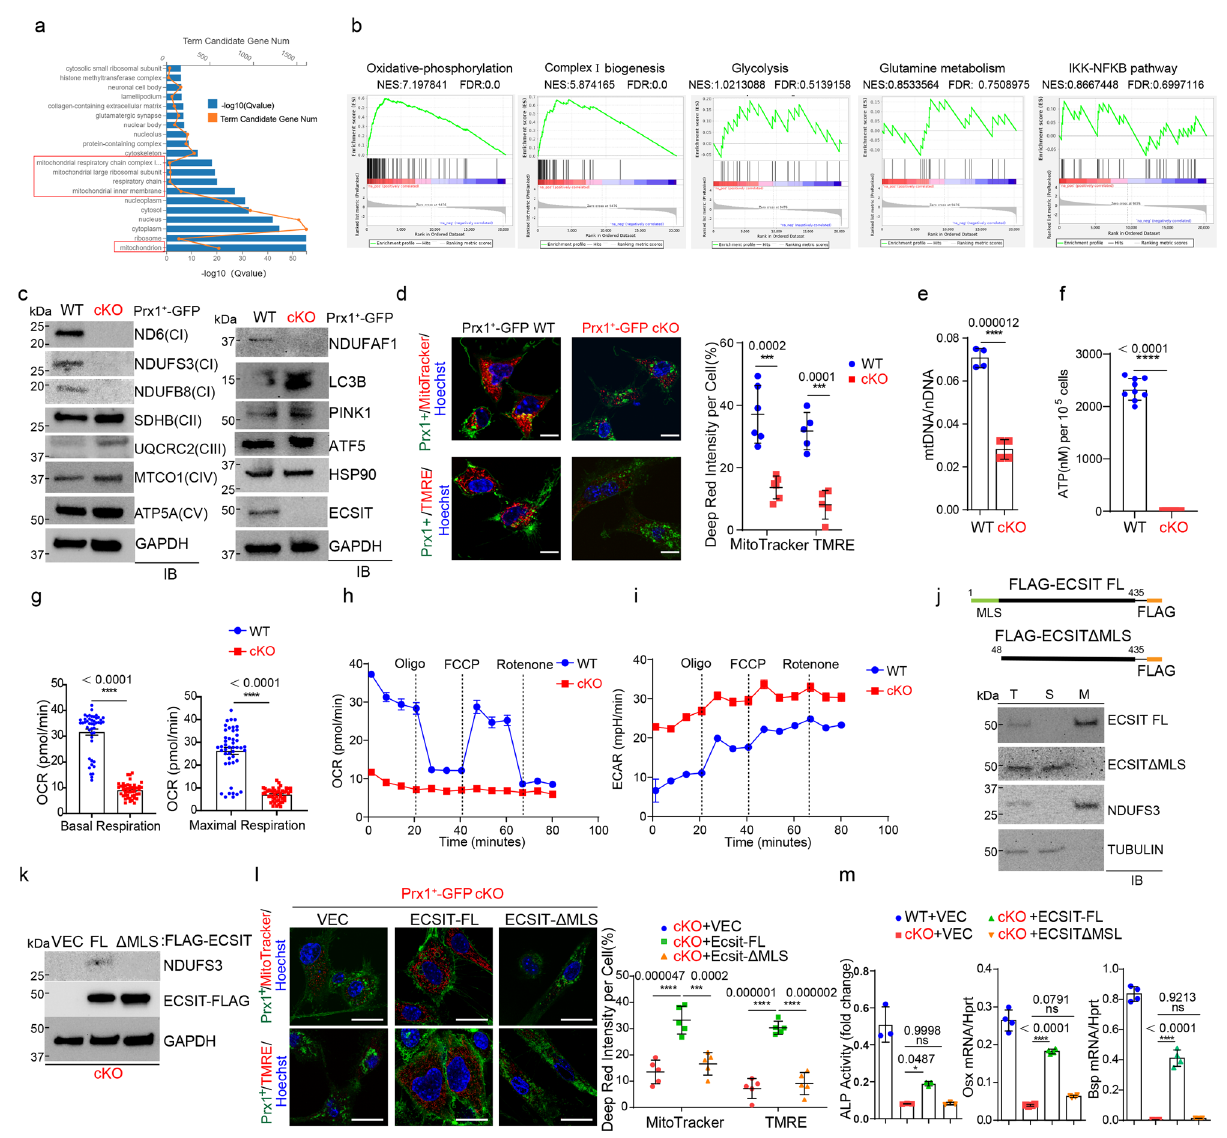
Fig.2| Ecsit -de fi ciencyinskeletalprogenitorsimpairsmitochondrialOXPHOS. a , b Gene ontology analysis showing biological processes with gene enrichment in cKO vs WT skeletal progenitors ( a ). Gene set enrichment analysis (GSEA) showing the enrichment of genes involved in OXPHOS, CI biogenesis, glycolysis, glutamine metabolism, and IKK-NF κ B signaling ( b ). c Immunoblot analysis showing protein levels in cKO and WT skeletal progenitors. GAPDH was used for a loading control. d MitoTracker and TMRE staining (red) of GFP-expressing cKO and WT skeletal progenitors (green). DAPI was used for nuclear staining ( left ). The signal intensity of the stained cells was quanti fi ed using ImageJ software ( right ). (MitoTracker (WT), n =6;MitoTracker(cKO),TMRE(WT,cKO), n =5). e RT-PCRanalysisshowing theratioofmitochondrialDNA(mtDNA,Ndufv1)tonuclearDNA(nDNA,18s)incKO andWTskeletalprogenitors( n =4). f IntracellularATPlevelsincKOandWTskeletal progenitors were measured by colorimetric analysis ( n =9). g – i . Seahorse assay showing a real time oxygen consumption rate (OCR, g – h ) and extracellular acid- i fi cation rate (ECAR, i ) of cKO and WT skeletal progenitors before and after the